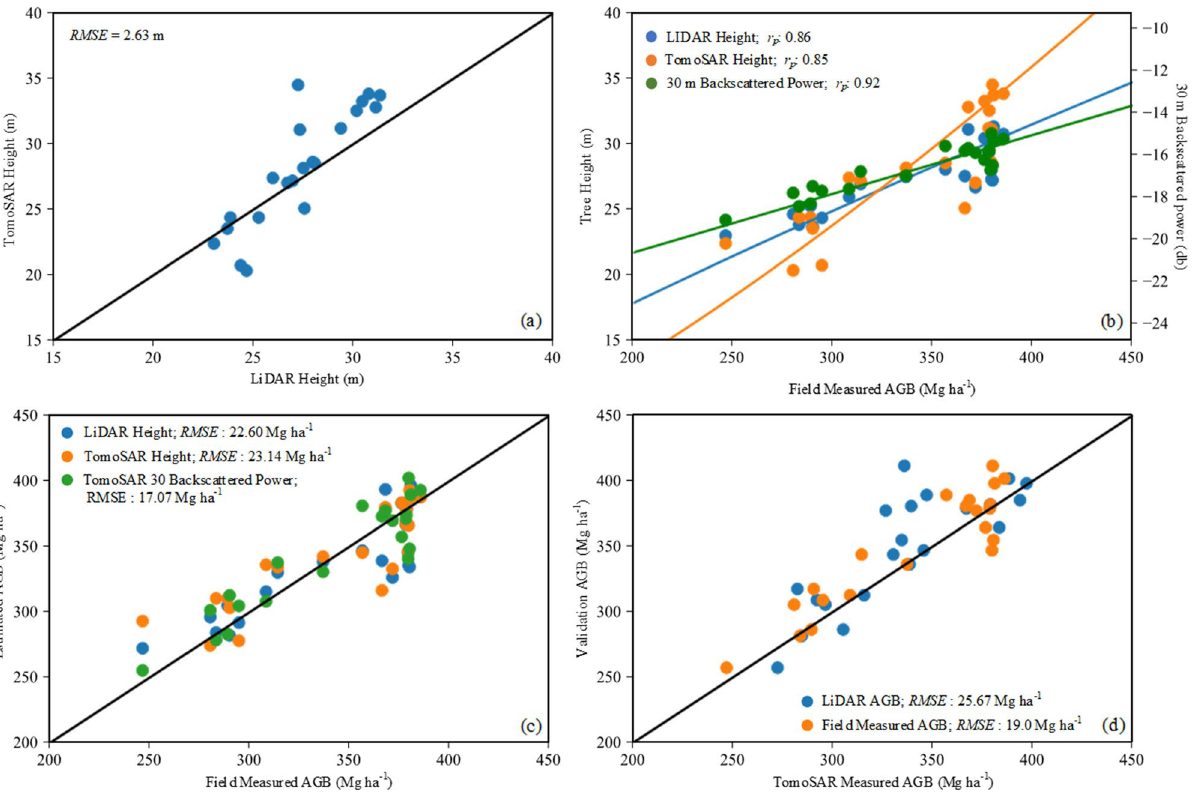
Figure 4. The TomoSAR AGB validation using field measured and LiDAR